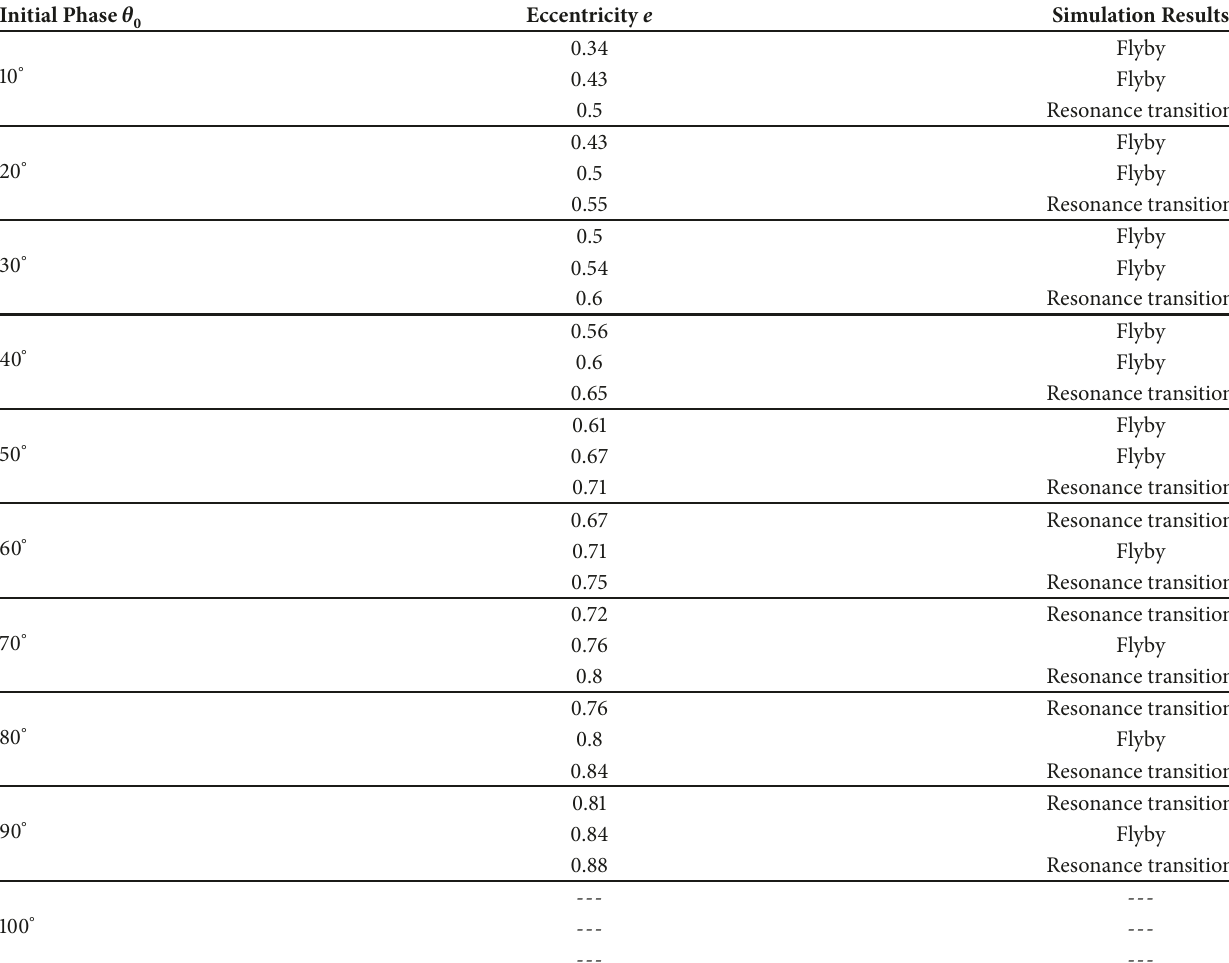
Figure 10: Flyby in the 1:2 resonant orbit with e = 0.7, 𝜃 0 = 60 ∘ . Table 1: Simulation results for the 1:2 resonant orbits when the initial parameterscan causethe closestdistance to lie within the Moon’s sphere of